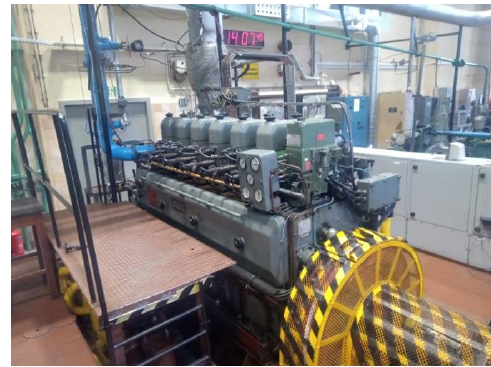
Fig. 1. The marine diesel engine laboratory stand